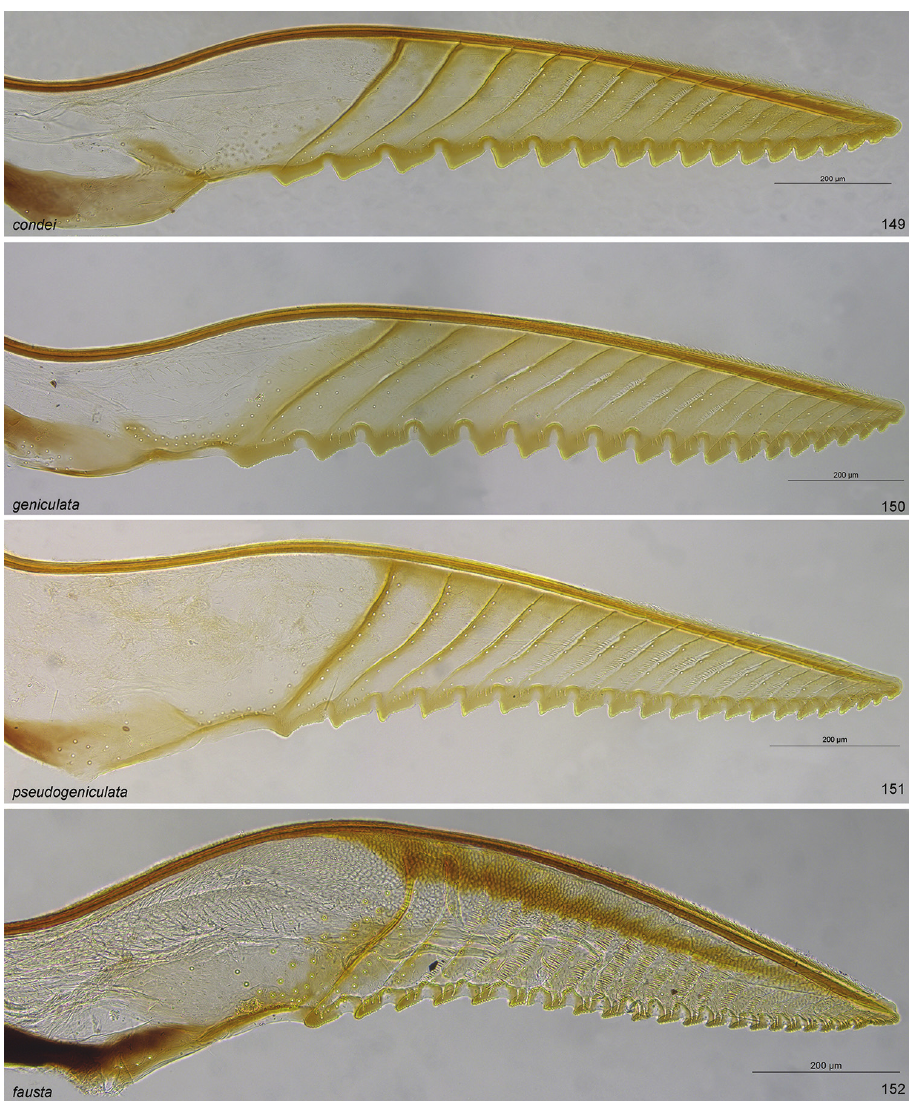
Figures 149–152. Lancets of Pristiphora . 149 condei PR.548VV 150 geniculata PR.550VV 151 pseu- dogeniculata holotype 152 fausta